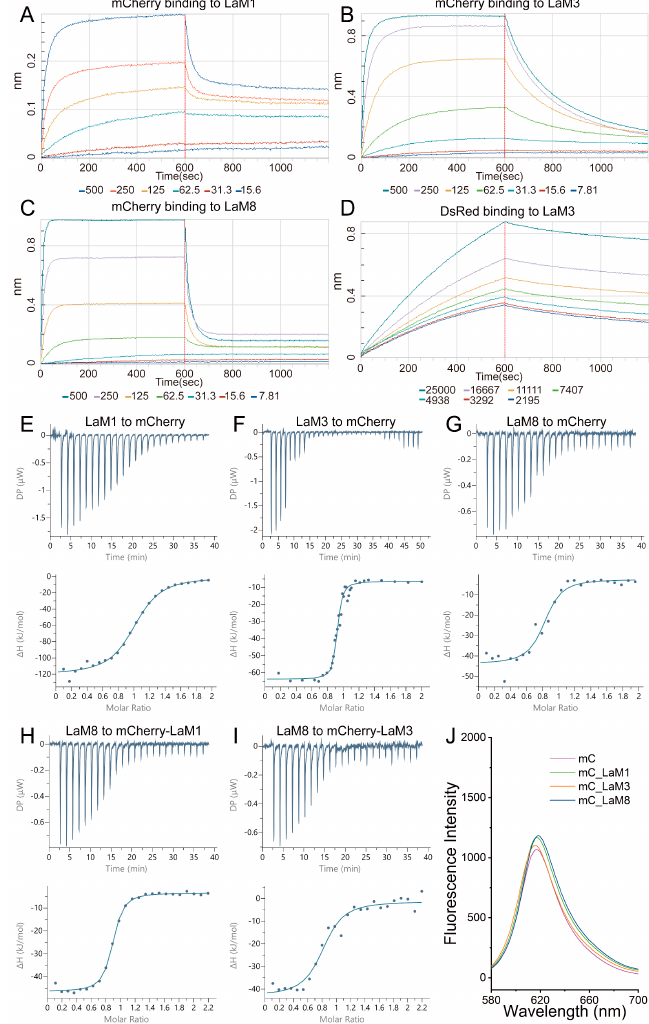
Figure 4. Characterize the binding kinetics and thermodynamic and fluorescence parameters of the binding between mCherry and LaM nanobodies ( A – D ) Binding kinetics of mCherry or DsRed with LaM nanobodies by BLI. Sumo − His tagged proteins were loaded onto Ni − NTA biosensors, then equilibrated before setting the baseline to zero at t = 0, and the association within mCherry or DsRed is in the range of 0 − 600 s. The dissociation in kinetics buffer is in the range of 600 − 1200 s. The x − axis represents time, and the y − axis represents the amount of protein binding to the biosensor. ( A – C ) A total of 100 nM His − SUMO − LaM1, His − SUMO − LaM3, and His − SUMO − LaM8 were loaded onto sensors, respectively, and 500, 250, 125, 62.5, 31.3, 15.6, and 0 nM mCherry tested for LaM1; 500, 250, 125, 62.5, 31.3, 15.6, 7.81, and 0 nM mCherry tested for LaM3 and LaM8 were assayed for association and dissociation. ( D ) A total of 100 nM His − SUMO − LaM3 were loaded onto sensors, and 25.4, 16.7, 11.1, 7.41, 4.94, 3.29, 2.20, and 0 µ M DsRed were assayed for association and dissociation. ( E – I ) Binding affinity of mCherry with LaM nanobodies by ITC. Each subfigure shows raw data (upper) and a fitted curve (lower). The x − axis of the upper panels represents time, and the y − axis represents differential power (DP) between the sample cell and the reference cell. The x − axis of the lower panels represents the molar ratio, and the y − axis represents the molar change of calories in the syringe. Dots represent the acquired data in experiments, and lines represent the fitted curve. ( E – G ) Result of ITC of 100 µ M LaM1, LaM3, LaM8, respectively, as syringe dropped into 10 µ M mCherry in the cell. ( H , I ) Result of ITC of 100 µ M LaM8 as syringe dropped into 8.9 µ M mCherry − LaM1 or mCherry − LaM3 in cell. ( J ) The emission fluorescence spectra of mCherry when binding with LaM nanobodies. The mCherry protein or mCherry − LaM complexes were excited by a laser at 560 nm, and the fluorescence intensity was detected in the wavelength range from 580 to 700